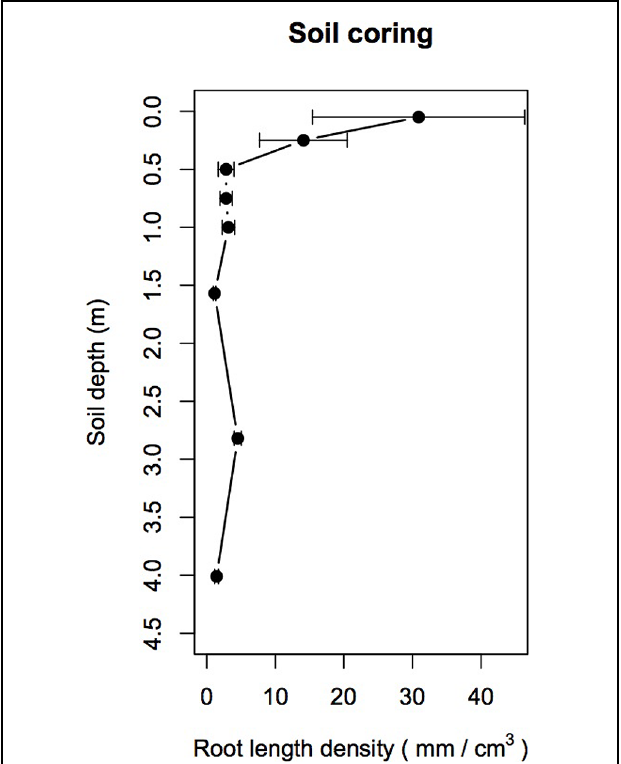
FIGURE 2 | Mean root length density (RLD mm/cm 3 ) derived from soil coring ( n = 12 per depth between 0.05 and 1.0 m; n = 5 below 1.0 m) as a function of soil depth. Note the significant decrease of RLD with increasing soil depth below 0.25 m and the relative increase of RLD between 2.5 and 3.0 m. Dots are mean values and error bars are 95% confidence intervals. FIGURE 3 | Mean root radius as a function of soil depth (dots) with